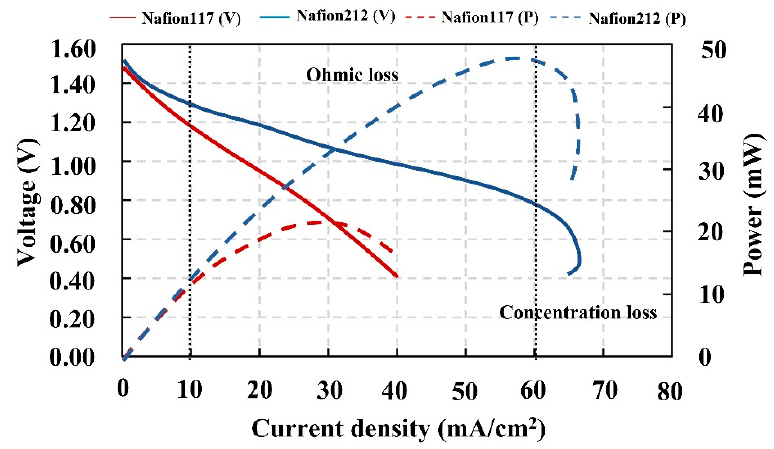
Figure 15. Polarization curves and power vs. current density plots of the VRFB containing various membranes.